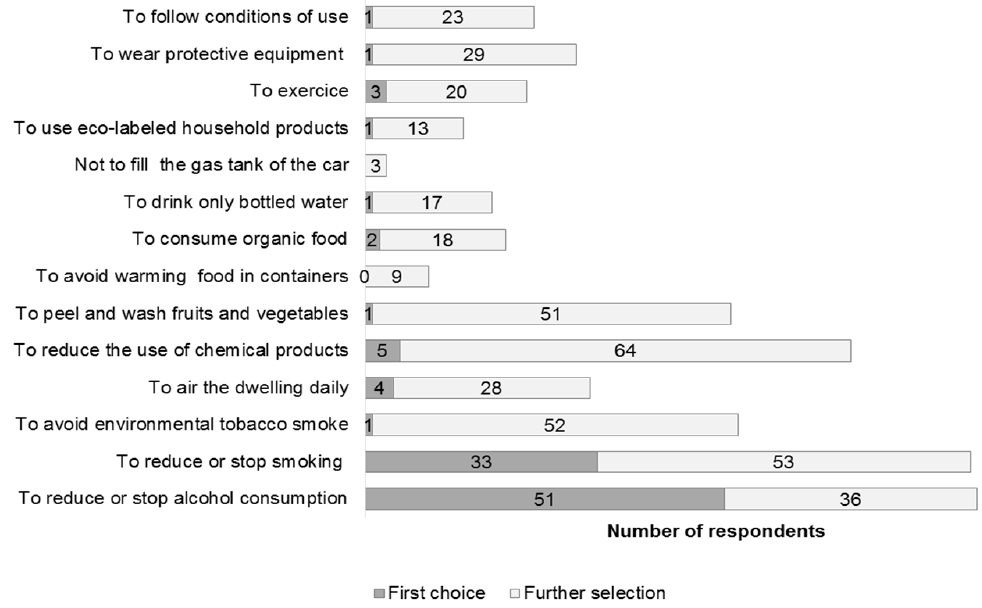
Figure 3. High priority actions chosen by women to improve their health during pregnancy ( n = 121).